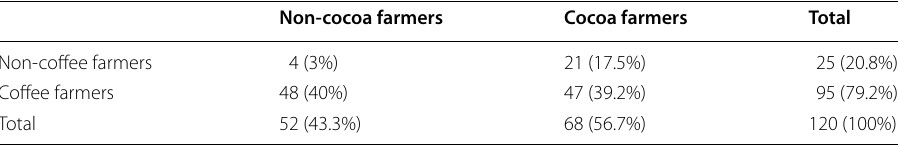
Table 2 Training participants in three locations (Tanggamus, South Lampung, and Garut- Ciamis) in